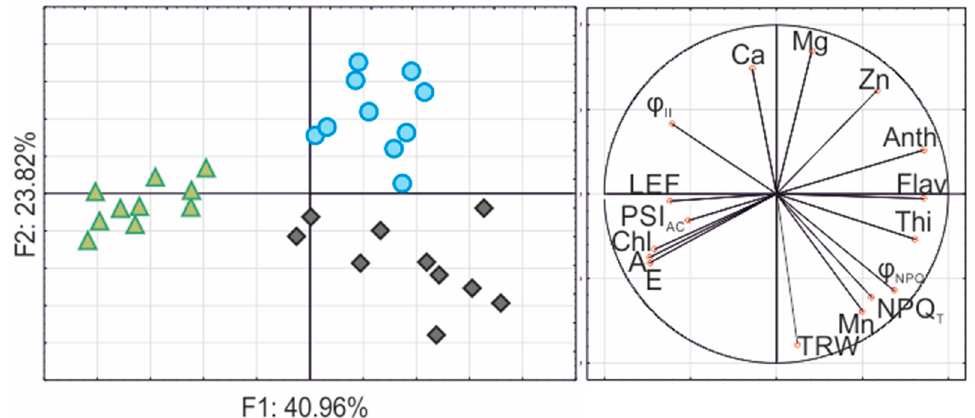
Figure 6. The Principal Component Analysis (PCA) presents the relationships between selected photosynthetic parameters, pigment content and element content of the silver birch from various sites. Legend: green triangle—reference population from Tychy; black rhombus—birch population from post-coal mine spoil heap; blue circle—birch population from post-smelter spoil heap. Abbreviations: Ca—calcium concentration in leaves; Mg—magnesium concentration in leaves; Mn—manganese concentration in leaves; Zn—zinc concentration in leaves; TRW—mean tree-ring width throughout the life of the tree; A—photosynthetic rate; E—transpiration rate; Thi—leaf thickness; Anth—anthocyanin content; Chl—chlorophyll content; Flav—flavonol content; NPQ T and φ NPQ —non-photochemical quenching; LEF—linear electron flow; φ II —quantum yield of photosystem II; PSI AC —active centres of photosystem I.